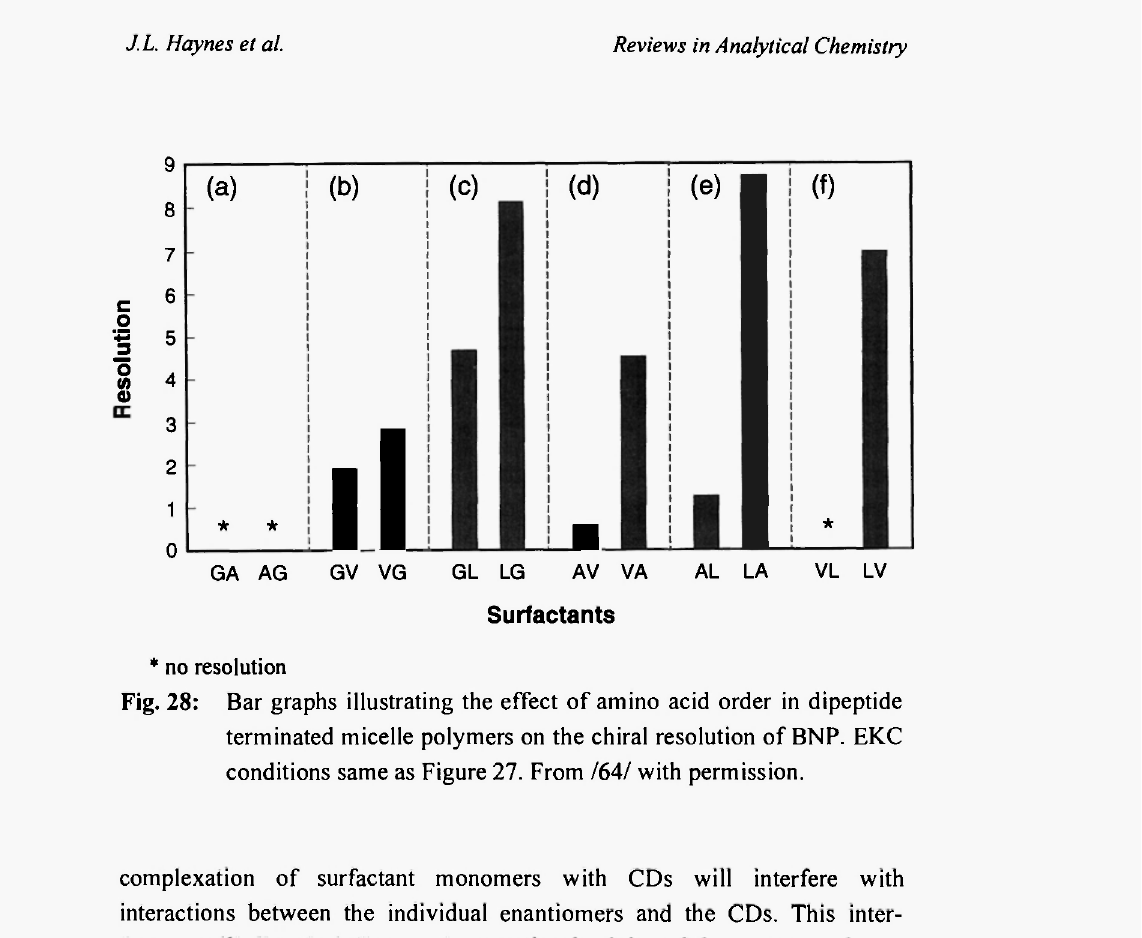
Fig. 28: Bar graphs illustrating the effect of amino acid order in dipeptide terminated micelle polymers on the chiral resolution of BNP. EKC conditions same as Figure 27. From /64/ with